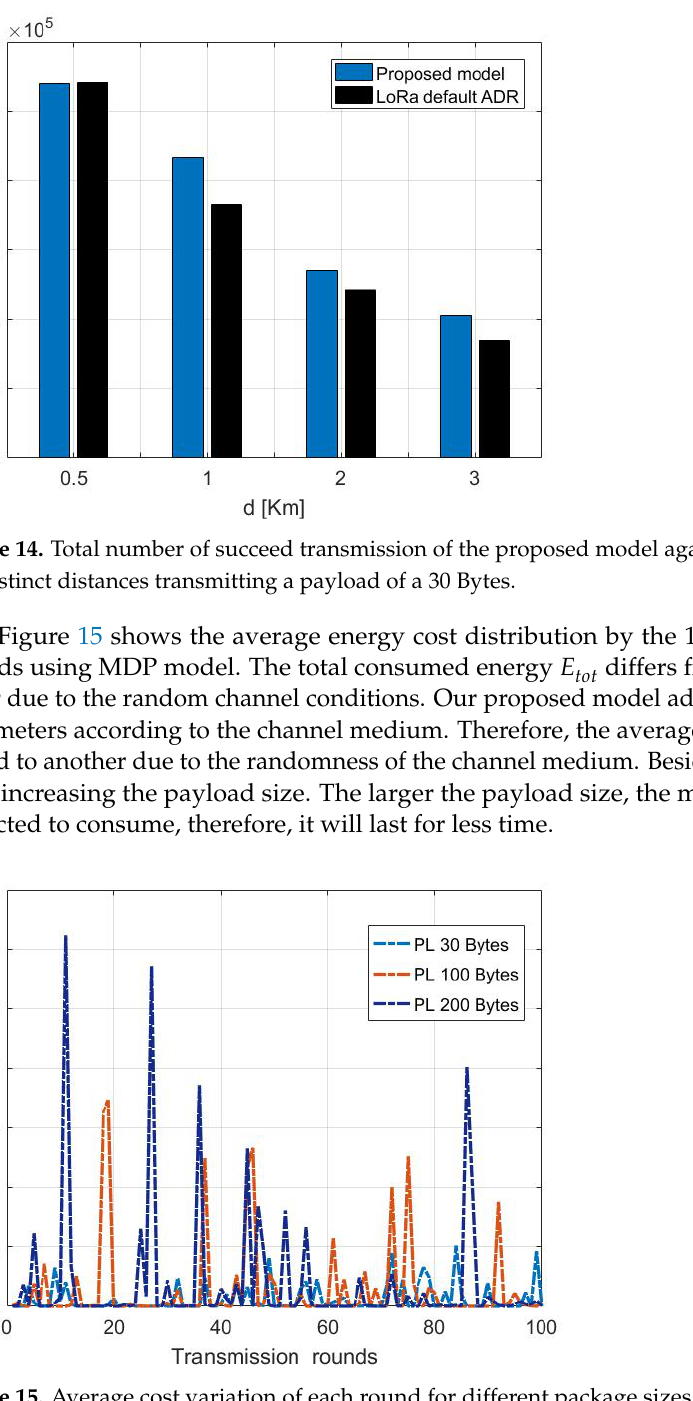
Figure 15. Average cost variation of each round for different package sizes from 3 km using MDP- based